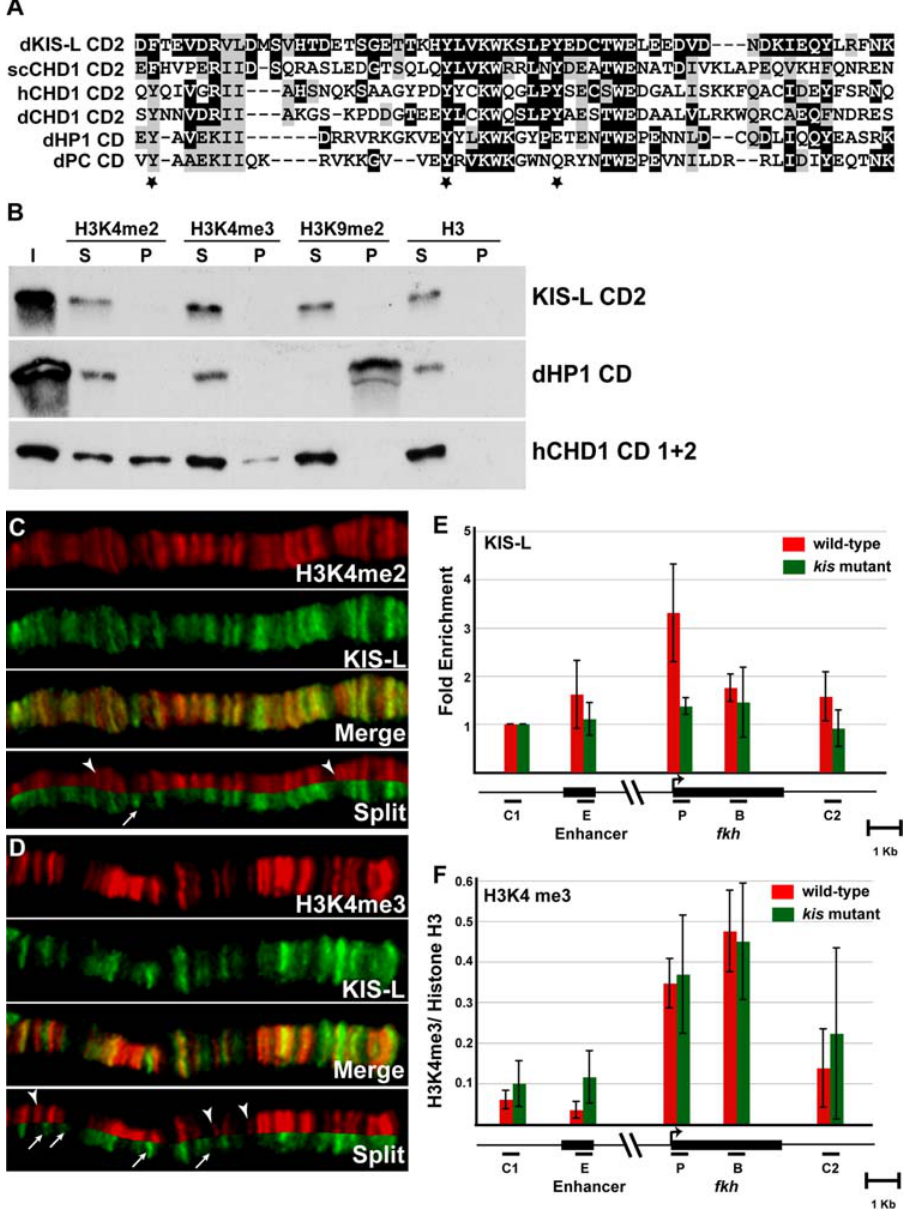
Figure 3. H3K4 methylation is not sufficient for the recruitment of KIS-L to chromatin. A) CD2 of KIS-L is aligned with CD2 of other CHD proteins and the chromodomains of Drosophila HP1 and PC. Identical and conserved amino acids are highlighted in black and grey, respectively. Aromatic amino acids that are important for binding of methylated histone tails by the CD2 of yeast CHD1 are marked by stars. B) The in vitro binding of HIS-tagged CD2 of KIS-L, CD1 and 2 of human CHD1 and the Drosophila HP1 chromodomain to histone H3K4me2, H3K4me3, H3K9me2 and histone H3 peptides were examined. Input (I), unbound protein (S) and the bound proteins (P) were detected by western blotting using anti-HIS tag antibody. Note that the chromodomains of HP1 and human CHD1, but not KIS-L, specifically bound methylated H3K9 and H3K4 peptides, respectively. C–D) The distributions of H3K4me2 (C, red) and H3K4me3 (D, red) were compared to that of KIS-L (C and D, green) on a representative region of wild-type polytene chromosomes. The arrowheads represent H3K4me2 and H3K4me3 bands that do not overlap with KIS-L, respectively, while the arrows represent bands of KIS-L that do not overlap with H3K4me2 and H3K4me3 bands, respectively. E–F) The distributions of KIS-L and H3K4me3 over the fkh gene were determined by ChIP using chromatin isolated from the salivary glands of wild-type (red bars) or kis k13416 (green bars) larvae. A map of the fkh gene is shown below the X axis; black bars represent the primers used to amplify the following regions: C1: region upstream of fkh , E: fkh enhancer, P: fkh transcription start site, B: fkh body, C2: region downstream of fkh . For KIS-L, the percentages of DNA immunoprecipitated for regions E, P, B and C2 were normalized to the percentage of DNA immunoprecipitated for region C1 (E). The ratio of DNA immunoprecipitated with antibodies against H3K4me3 and histone H3 are shown for each region (F). Note that KIS-L is enriched over the transcription start site of fkh while H3K4me3 is enriched over both the transcription start site and the body of fkh gene. The bars represent the average of independent biological experiments (n=4 for H3K4me3 and n=5 for KIS-L) with the corresponding standard deviations.